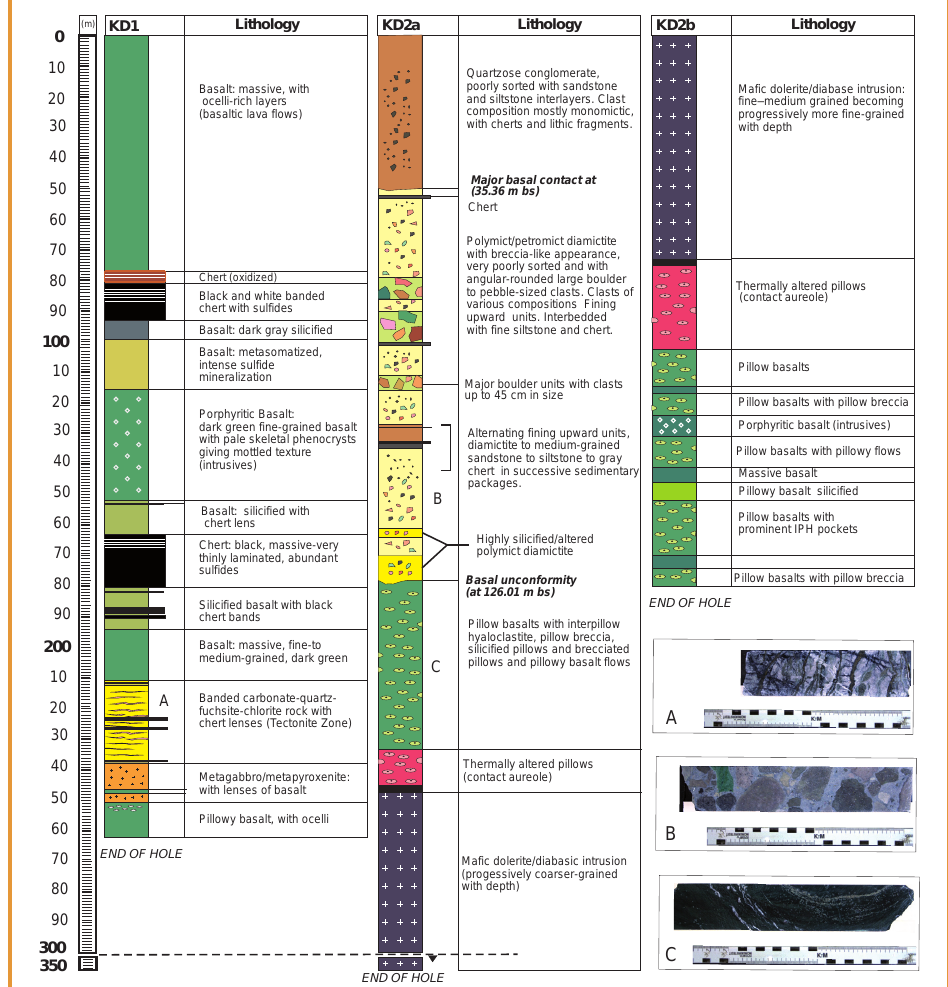
Figure 3. Simplified diagrams of geological logs for KD1, KD2a, and KD2b. The labelled photographs of selected core sections in the inset [A–C] correspond to the labels indicated at different depths in the three logs. [A] Carbonate-quartz and fuchsite-chlorite bands in the tectonite zone of KD1. [B] Example of shape, size, and variety of clasts occurring in the diamictite unit that directly overlies pillow basalts at the unconformity in KD2a. [C] Drill core section through a pillow basalt consisting of an ocelli-rich pillow core, outer ocelli-poor glassy pillow rim, and veined and sulfide-bearing interpillow